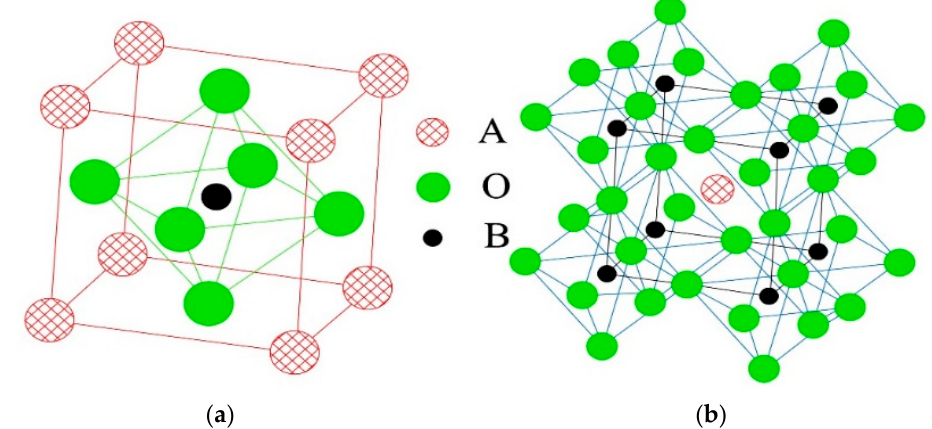
Figure 1. Perovskite ‐ type crystal structure: ( a ) Cubic unit cell; ( b ) Oxygen octahedral structure.